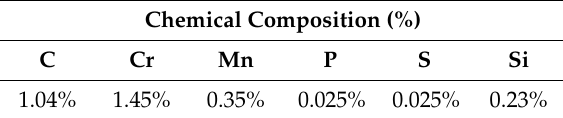
Figure 2. ( a ) Turning geometry model; ( b ) 3-D turning finite element model. Table 3. Major chemical components of AISI52100 hardened